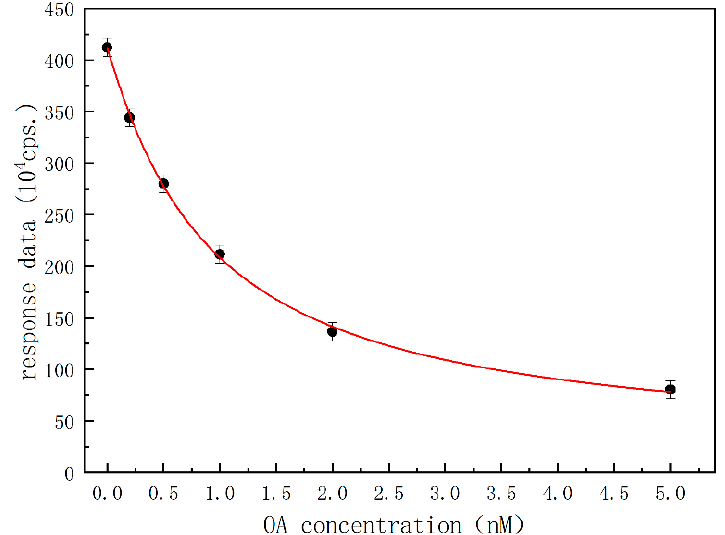
Figure 6. Calibration curve of OA with datapoints of black dots.